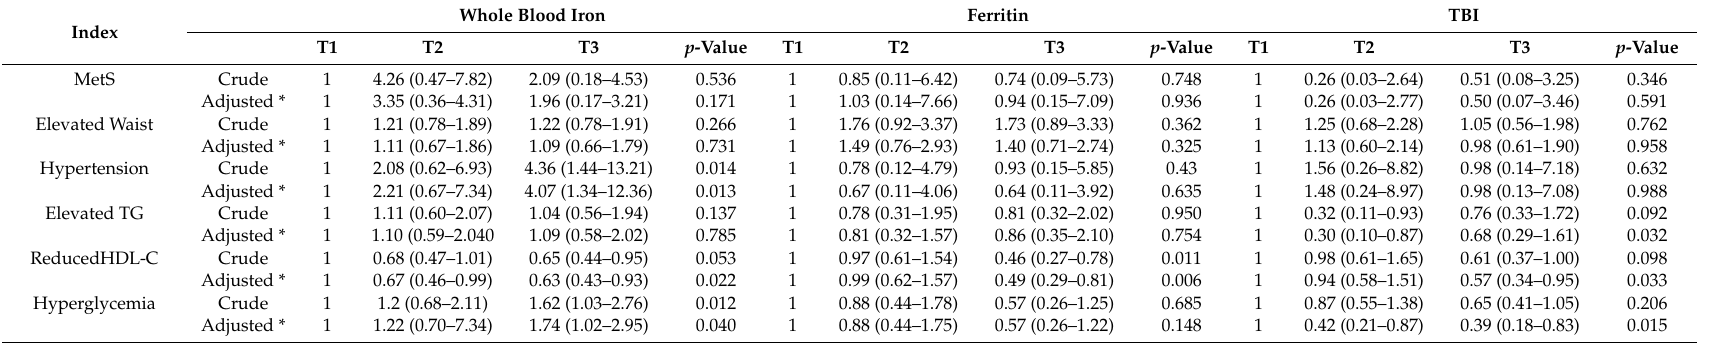
Table 3. Odds ratios for MetS and its components according to di ff erent markers of iron